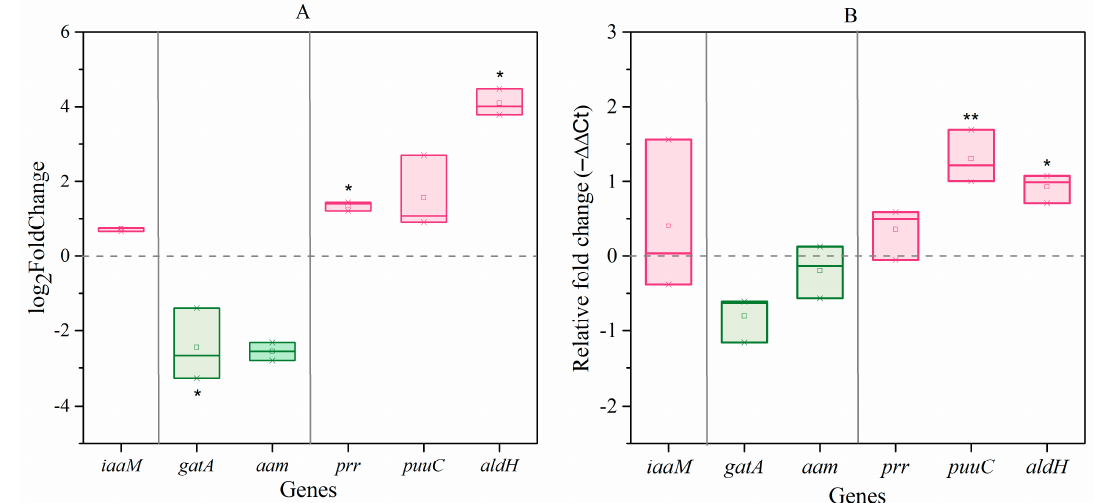
Figure 4. Effects of C. elegans extracts on the expression of genes involved in IAA biosynthesis in A. pascens ZZ21. ( A ) Results of transcriptome sequencing analysis ( p < 0.05 and |log2(fold change)| > 1.5). ( B ) Results of qRT-PCR analysis. Asterisks indicate significant differences (* p < 0.05, ** p < 0.01).